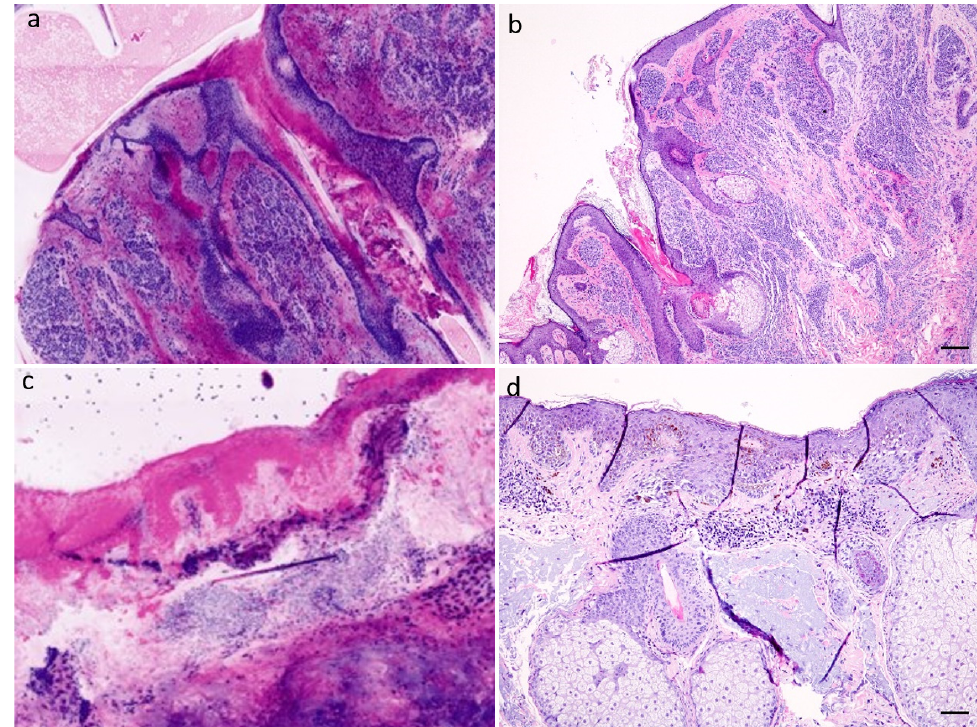
Figure 2. Melanocytic tumors ( a ) papillomatous dermal nevus, CLSM ( b ) papillomatous dermal nevus, H&E-stain, scale = 250 µm ( c ) lentigo maligna (melanoma in situ), CLSM; ( d ) lentigo maligna, H&E-stain, scale = 100 µm.